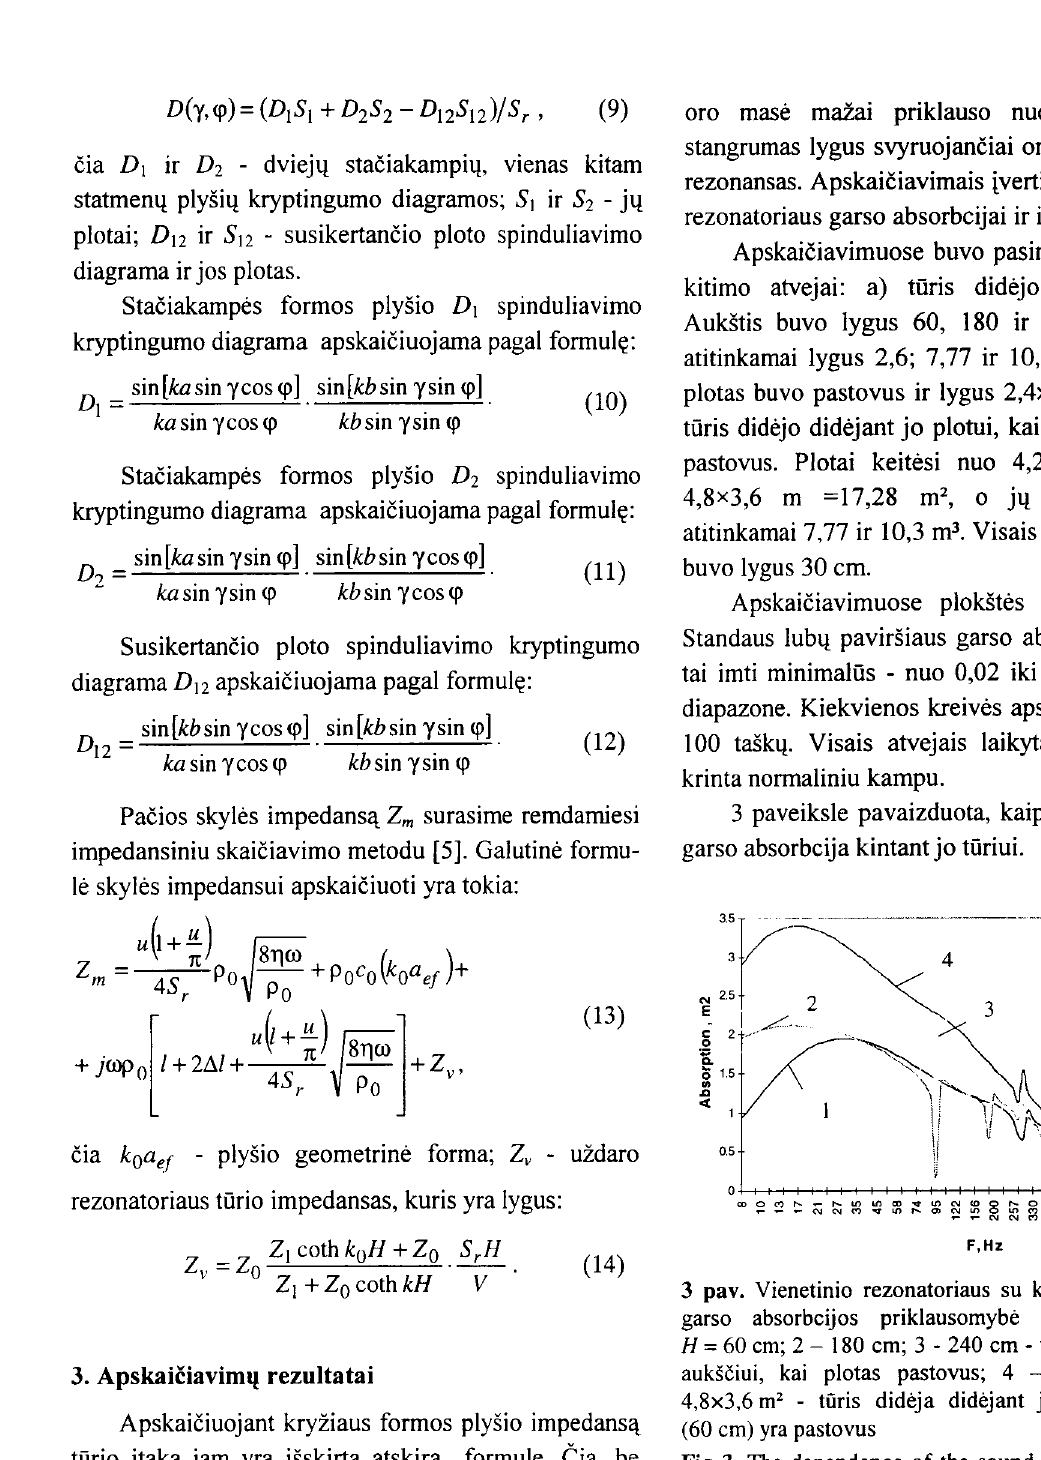
Fig 3. The dependence of the sound absorption of a cross shaped acoustic resonator on its volume: 1 - H = 60 em; 2 - 180 em; 3 - 240 em - the volume is increased along with the height increase with the area being constant; 4 - S